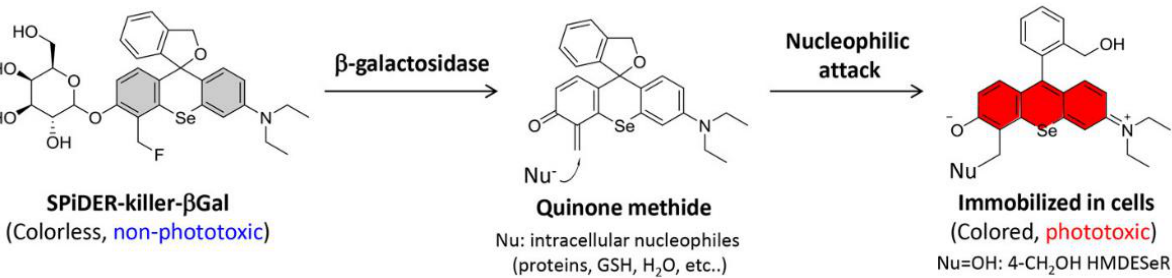
Figure 12. Activaton of SPiDER-killer- β Gal. Adapted with permission from [56], copyright 2019 American Chemical Society.